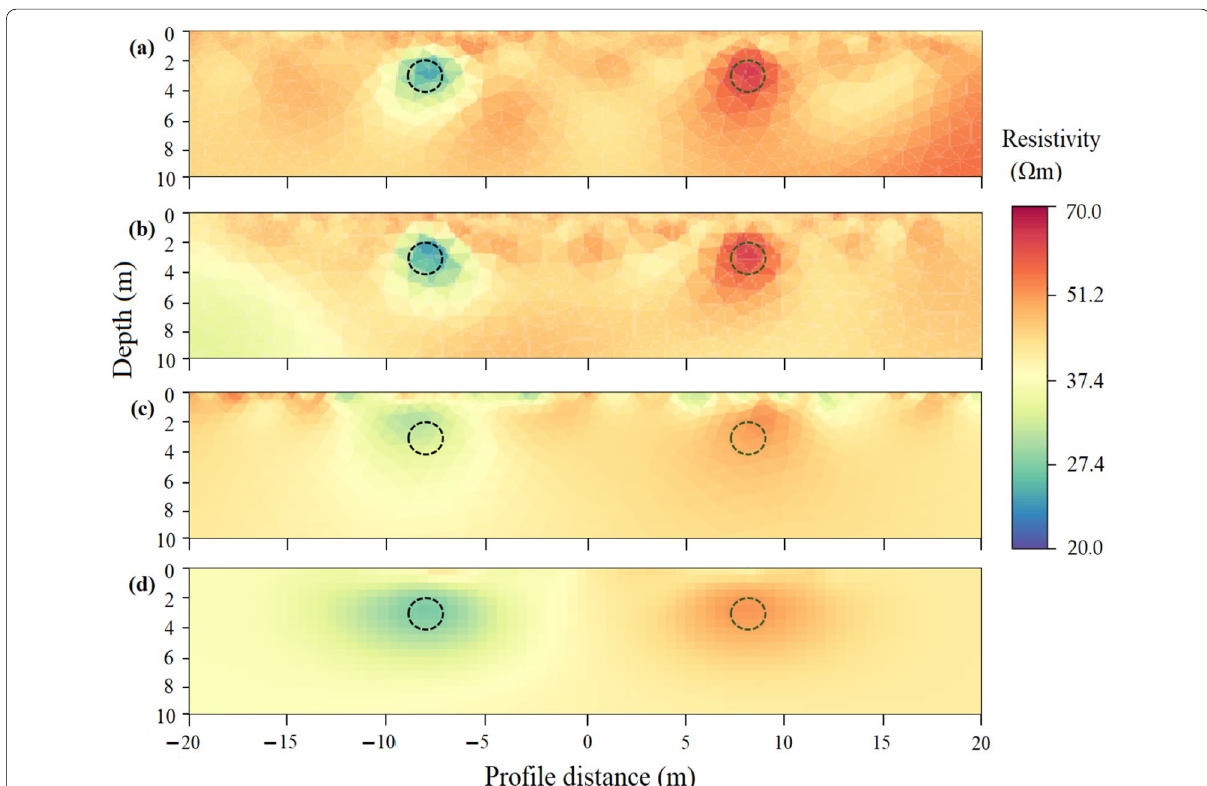
Fig. 10 The recovered model of scenario two for a 1 m target radius situated at 3 m depth applying the inversion freeware: a pyGIMLi, b BERT, c ResIPy, and d SimPEG. The broken circles show the actual targets; the left for conductive while the right for resistive target. pyGIMLi, BERT, and ResIPy use unstructured triangular mesh, while SimPEG implements tensor